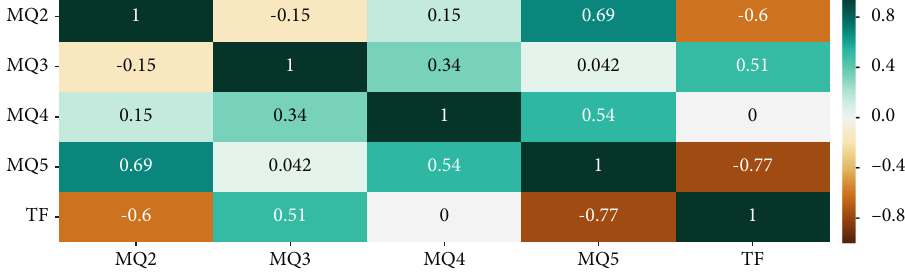
Figure 8: Correlation between the two variables—first peak analysis.